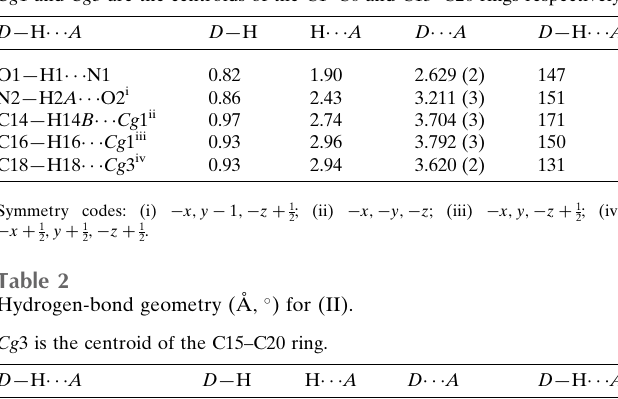
Table 1 Hydrogen-bond geometry (A˚ , (cid:2) ) for (I).